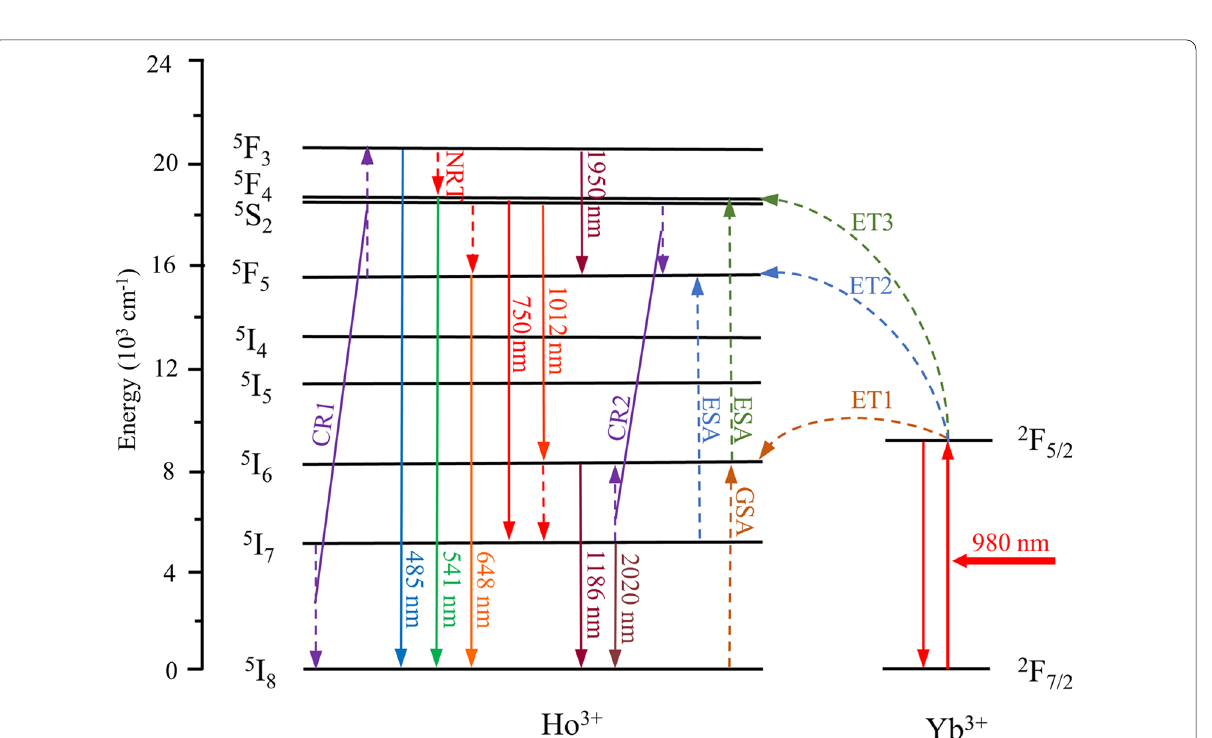
Fig. 3 The energy level diagram for SrF 2 :Yb 3 + /Ho 3 + NCs excited at 980 nm. The corresponding processes of ET, ESA, CR and NRT are also